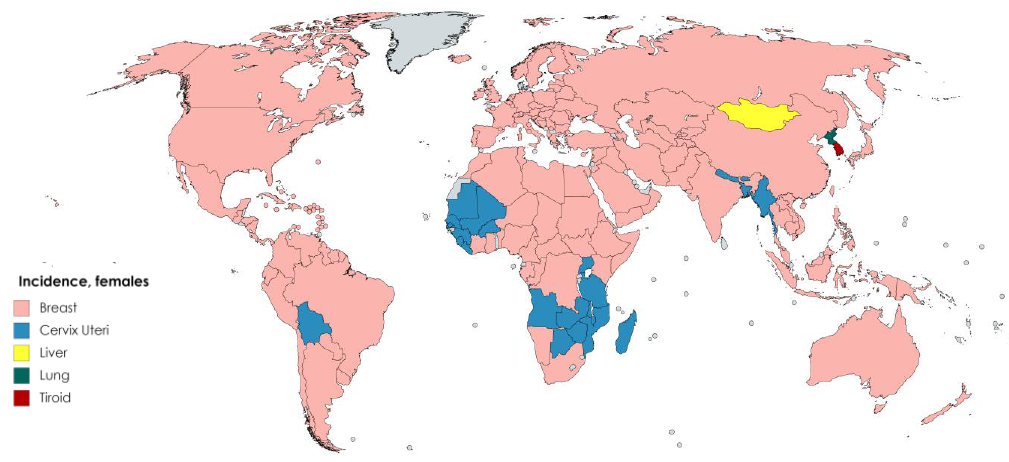
Figure 7. Worldwide cancer incidence by type in females [2]. Created with mapchart.net.